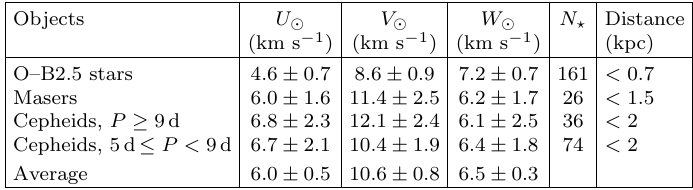
Table 2. Components of the peculiar velocity of the Sun with respect to the LSR, calculated taking into account both the differential Galactic rotation and the perturbations due to the spiral density wave. Objects U ⊙ V ⊙ W ⊙